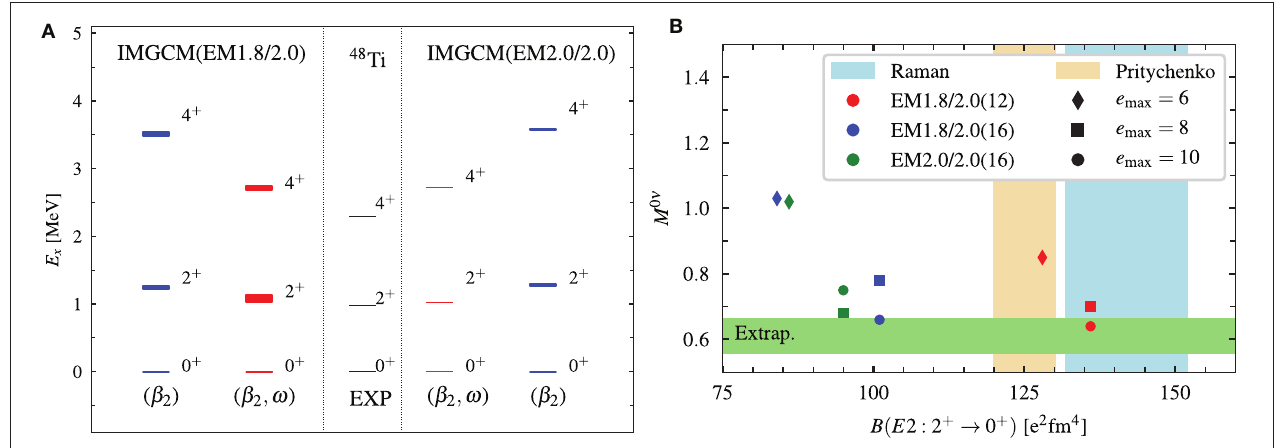
FIGURE 11 | IM-GCM description of the neutrinoless double beta decay 48 Ca → 48 Ti, using EM λ/3 interactions: Low-lying spectrum of 48 Ti and its compression through the admixing of cranked configurations (A) and the nuclear matrix element vs. B(E2) transition probability (B) . See text and reference [29] for details. (A) courtesy of J. M. Yao, (B) reprinted with permission from the American Physical